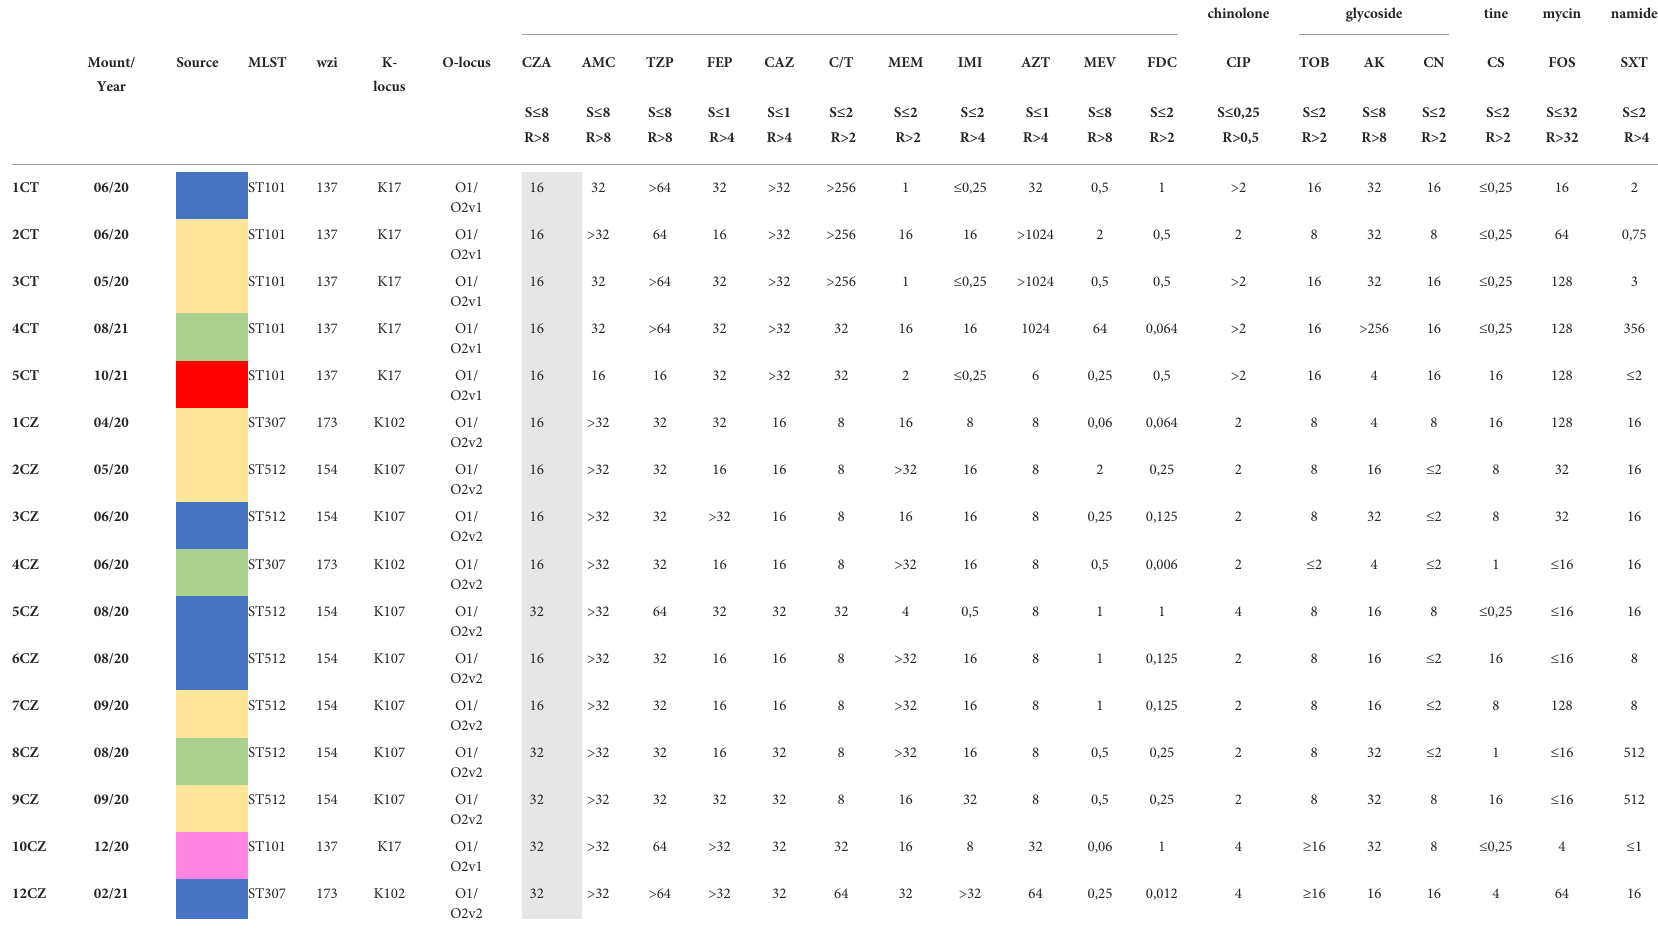
TABLE 1 Phenotypic and Molecular Characterization and Resistance Pro fi le of the K. pneumonia